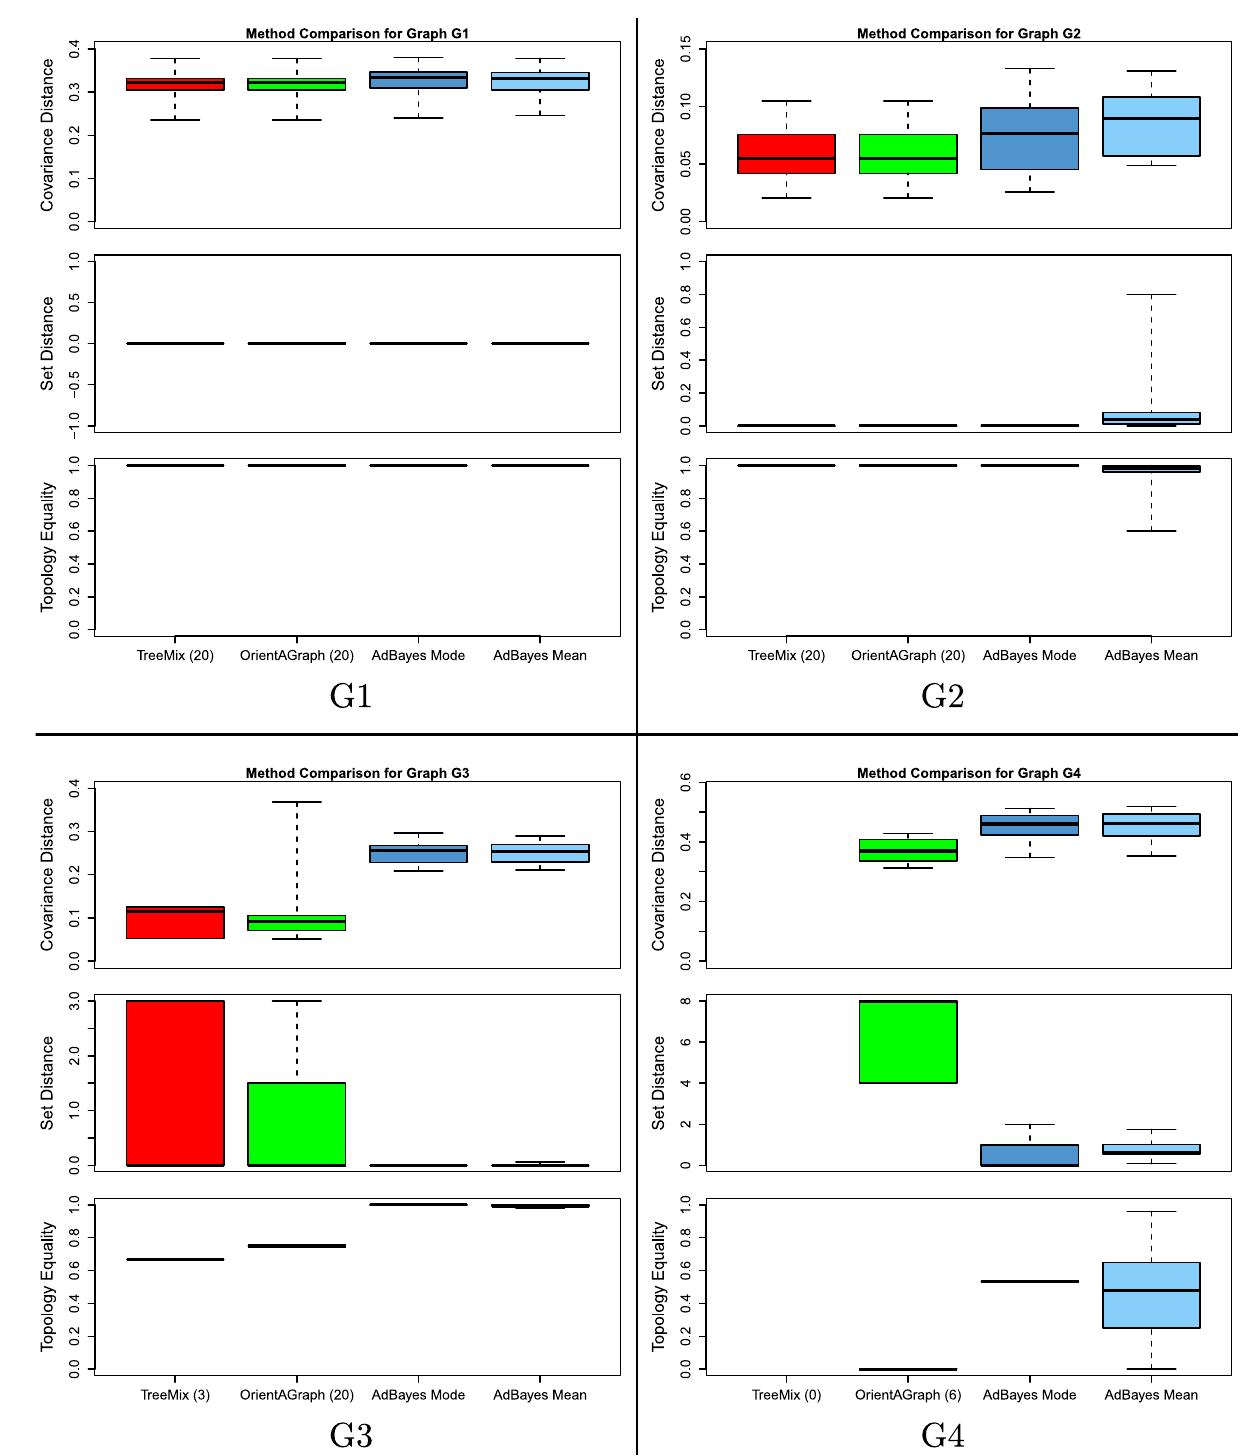
Fig 2. We here plot the results of our method comparison with TreeMix and OrientAGraph. For each of the graphs in Fig 1, we simulated 20 datasets and ran each method on each dataset. We compared the accuracy of each method with the 3 statistics discussed in the section Comparisons with TreeMix and OrientAGraph. For AdmixtureBayes, we examined both the Mode graph (the sampled graph with the highest posterior) and the mean value of the statistics when 100 graphs are sampled from the posterior (we refer to this as the AdmixtureBayes Mean). TreeMix and OrientAGraph allow admixture involving the outgroup, an error which AdmixtureBayes is not allowed to make. For fairness, we only plot the results for the graphs not